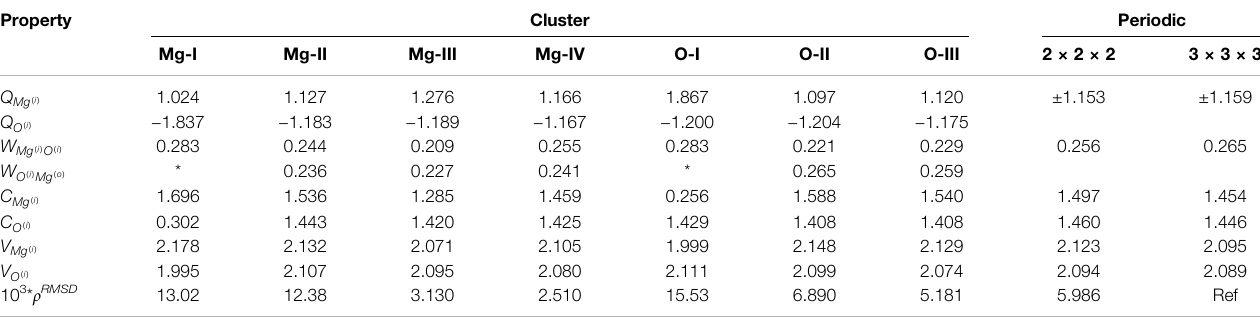
TABLE 2 | Electronic structure of clusters with Mg- on O- center. Table showing the convergences of Mulliken charges ( Q ), Wiberg bond indices ( W ), covalency ( C ), total valency ( V ) and integrated density difference Δ ρ (multiplied by a factor of 10 3 ) with respect to periodic values. * indicates that the value is unde fi ned for the particular cluster. Cluster